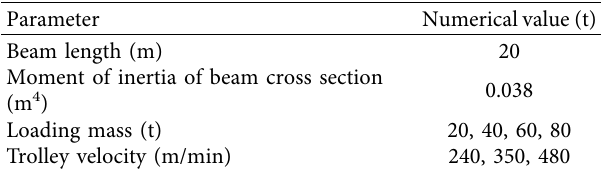
Figure 7: Extrusion and wear of rail pad in rail joint region: (a) the height difference of track joints changing when the trolley passes, (b) site of replacement of trolley track backing plate, (c) squeeze and wear of rail pad, and (d) thickness of backing plate of quay crane track after use. Table 1: Parameters of dynamic equilibrium equations